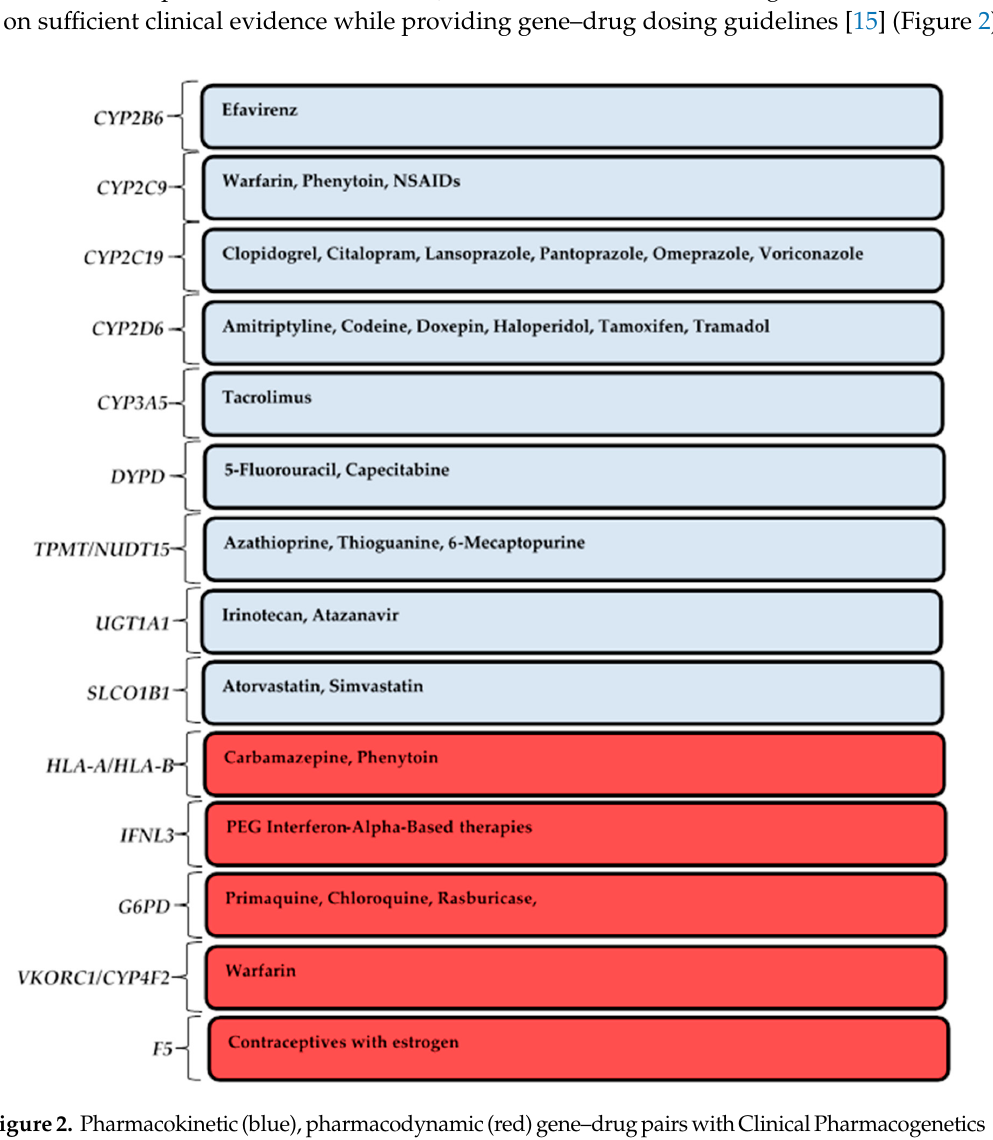
Figure 2. Pharmacokinetic (blue), pharmacodynamic (red) gene–drug pairs with